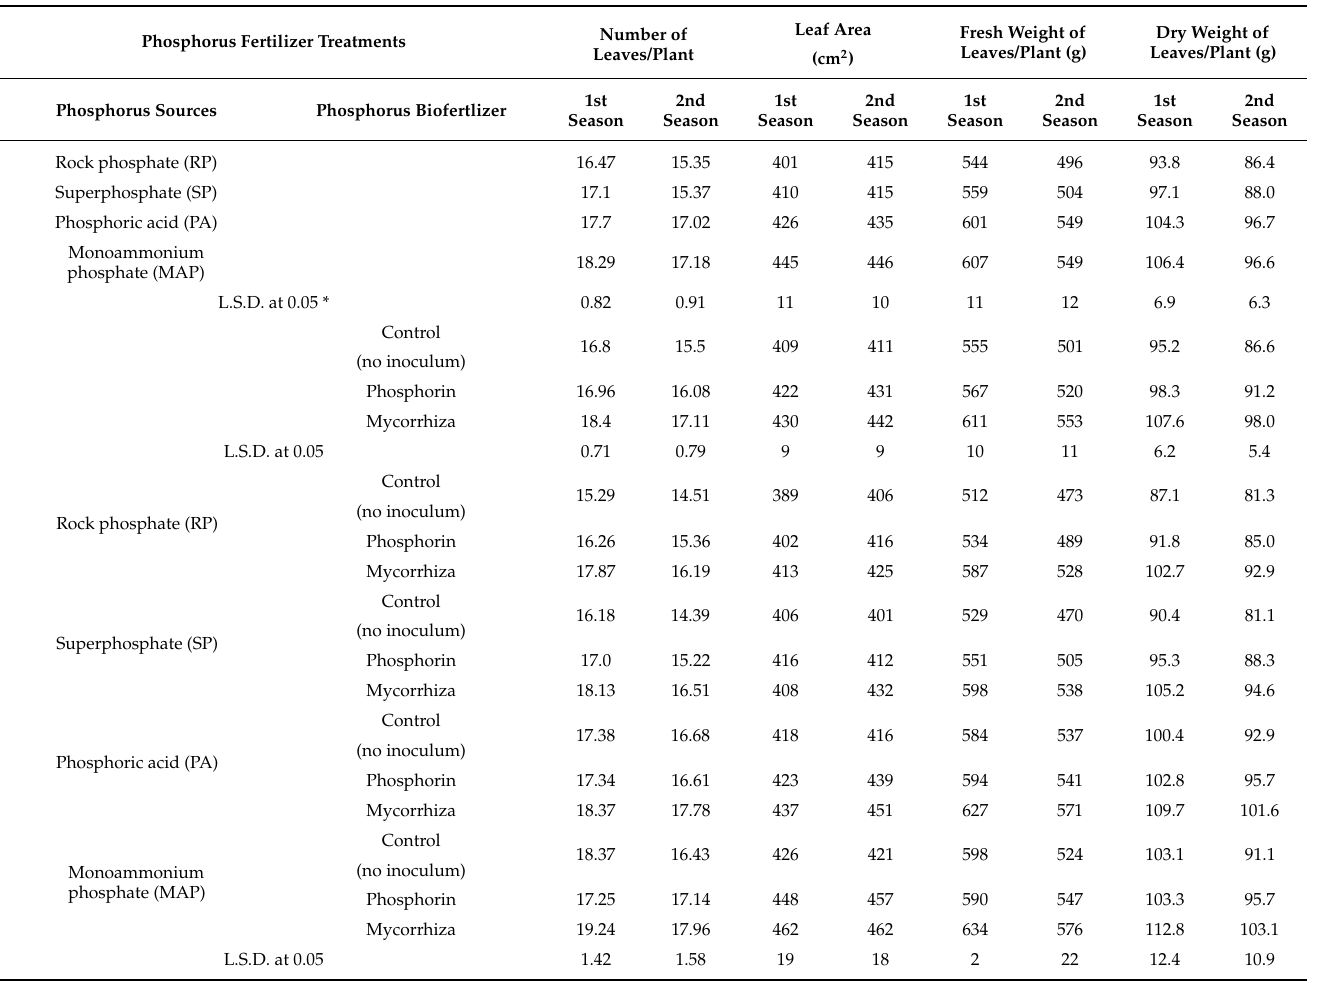
Table 5. The effect of phosphorus source and bio-fertilizers application on vegetative growth parameters of broccoli plants during the 2018 (1st) and 2019 (2nd) seasons. Phosphorus Fertilizer